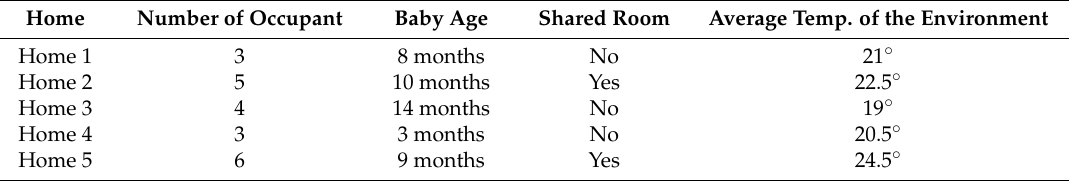
Table 4. Description of households in which the designed system was deployed.